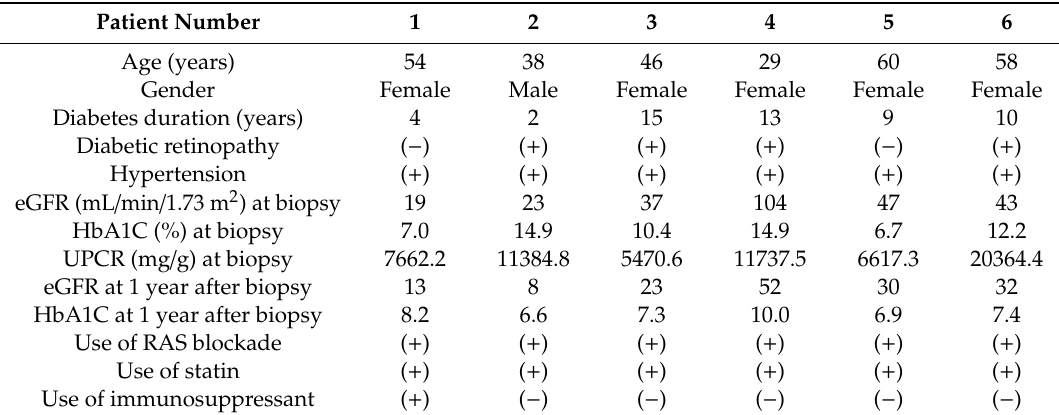
Table 1. Characteristics and clinical data of the study